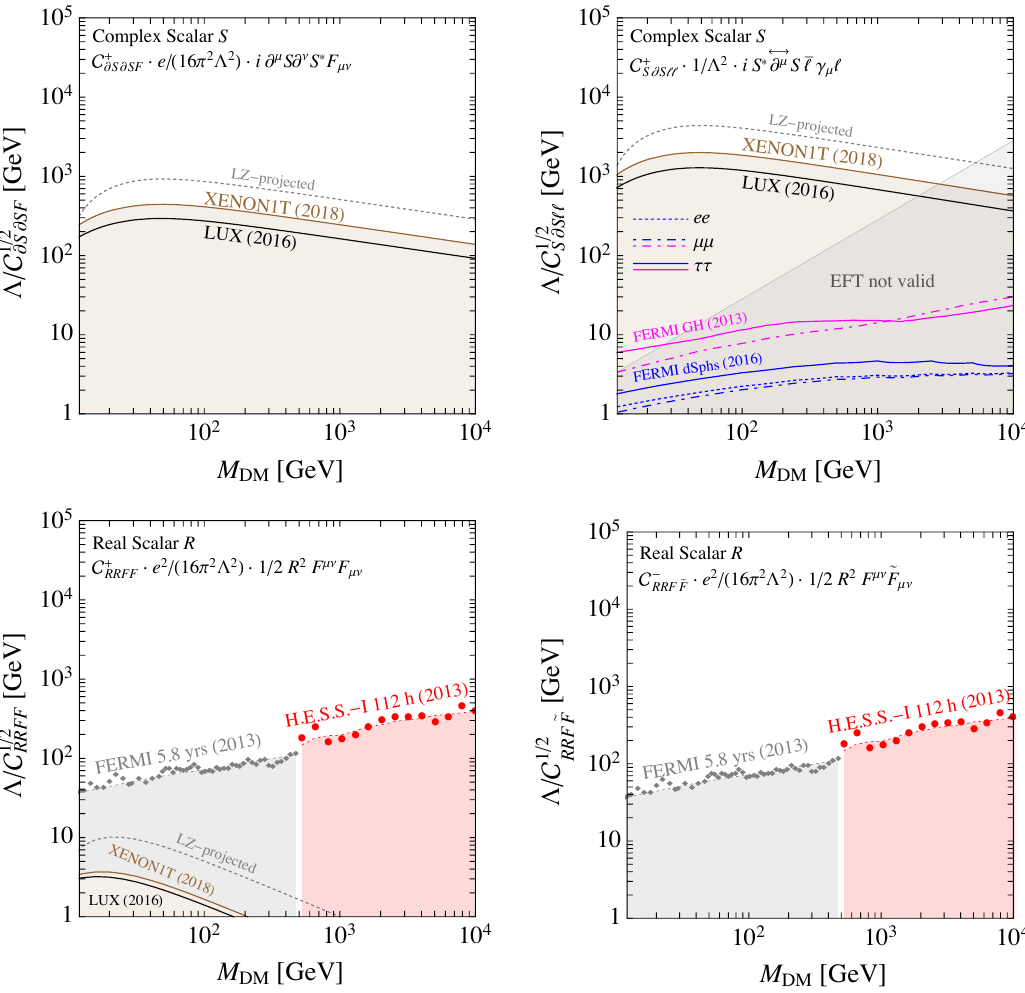
Figure 3 . Same as (cid:12)gure 1 but for Scalar Dark Matter. In the top row, we consider operators for complex scalar DM S and in the bottom row we consider real scalar DM R